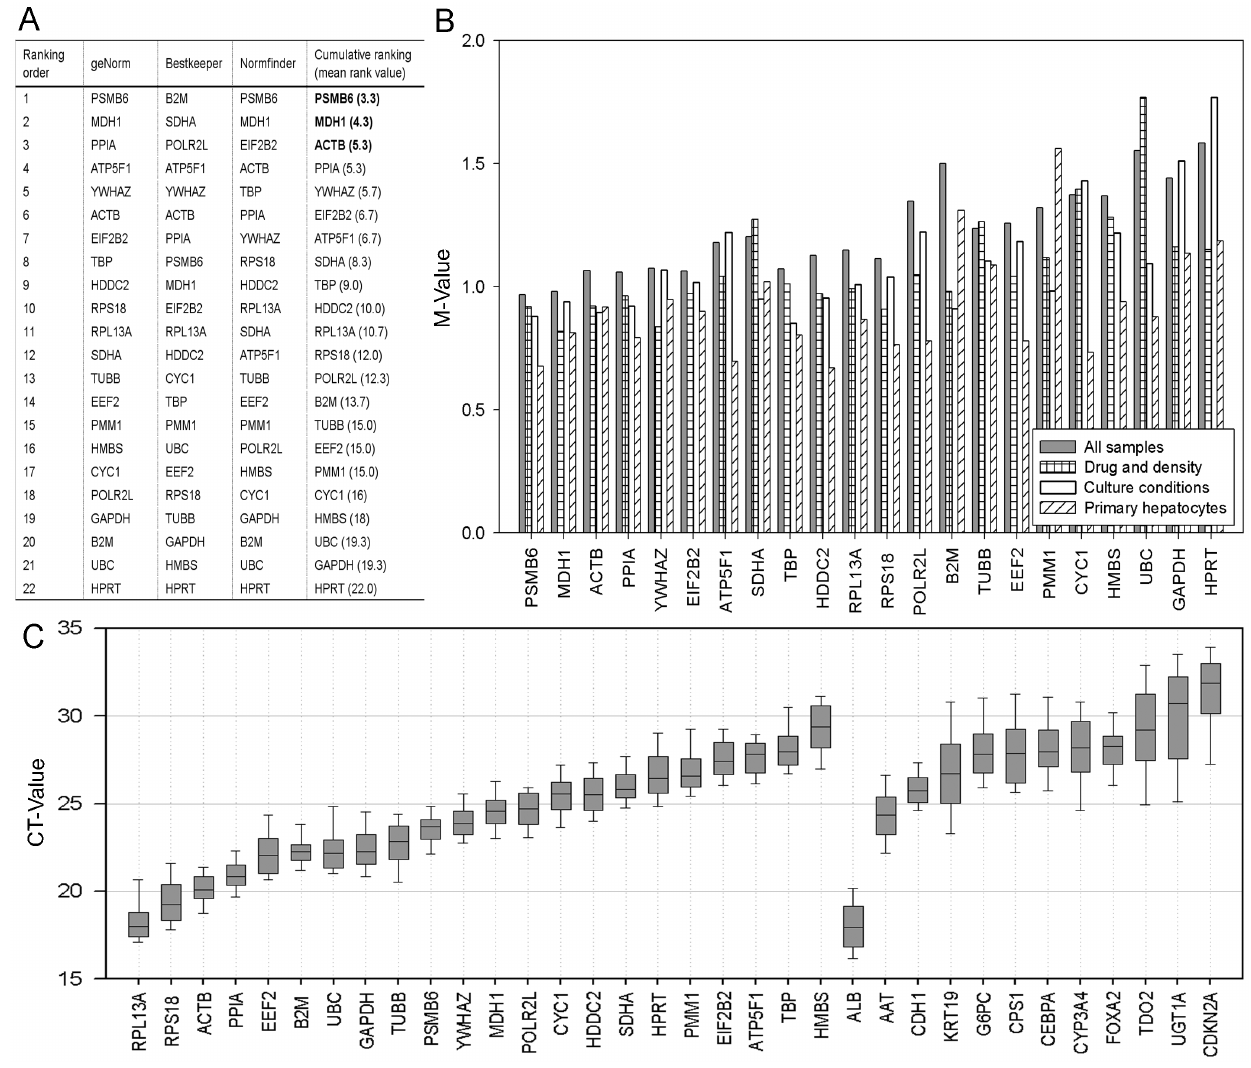
Fig. 1. Evaluation and ranking of reference genes. (A) Overall ranking of 22 RG using geNorm, Bestkeeper and Normfinder algorithms and calculation of the cumulative ranking (column 4). (B) geNorm derived M-values as measures for the average pairwise expression stabilities within AS (column 1), and in the subgroups DD (2), CC (3) and PH (4). (C) Box-whisker plots of all CT-values of reference genes and target genes examined. Median (central horizontal line), the 25th and 75th quartile (boxes) and whiskers for the total CT-range are